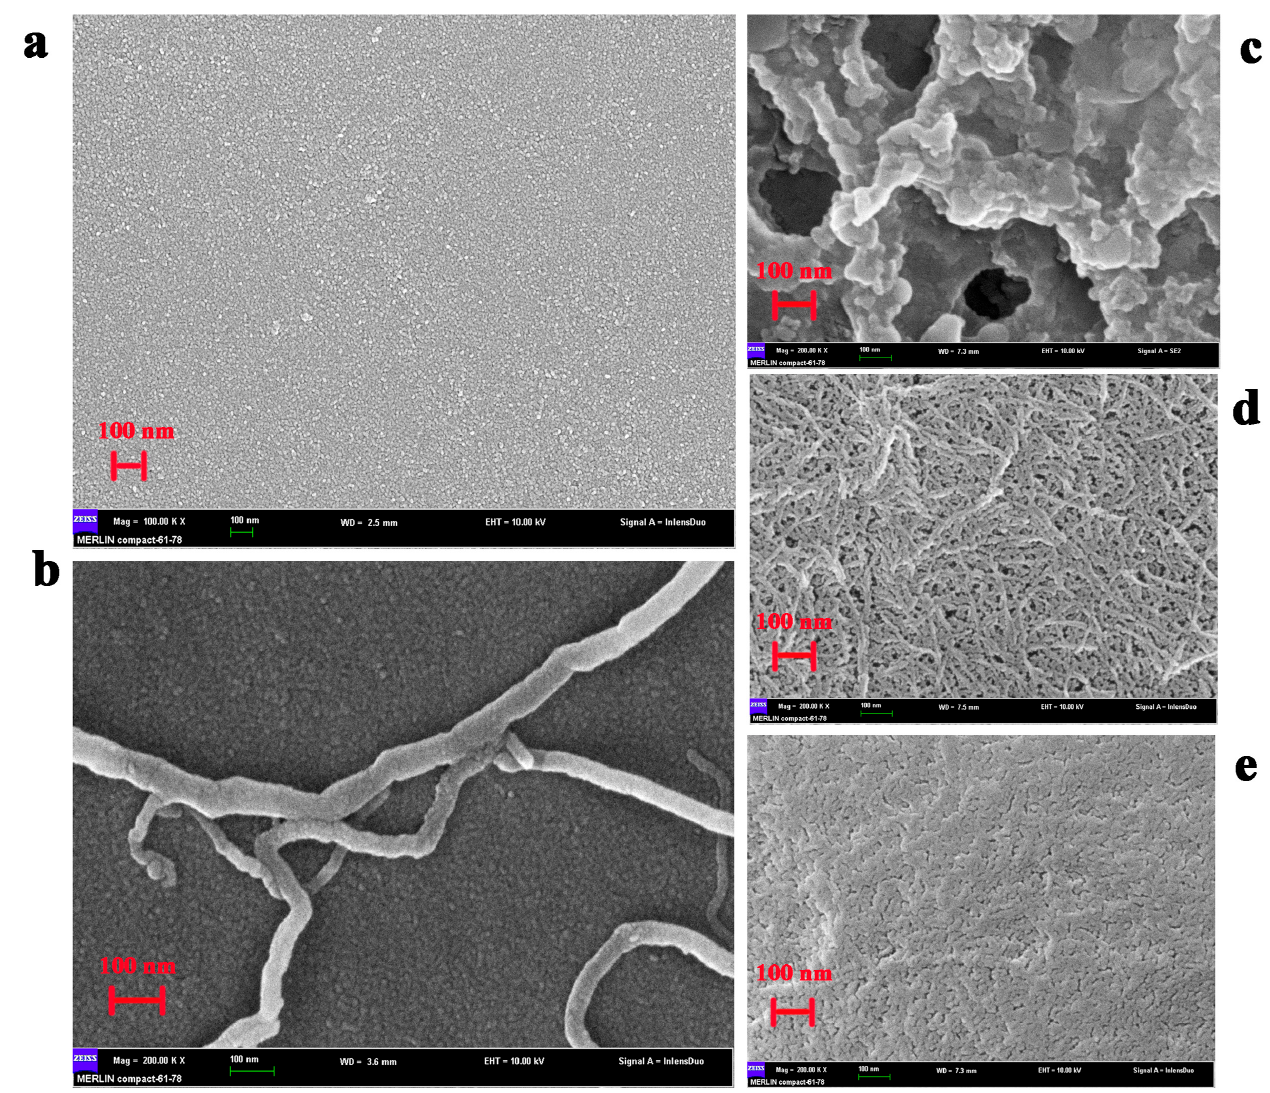
Figure 3. SEM images of the GCE electrode surface modified with distinct methods. ( a ) bare GCE; ( b ) S-MWNT/GCE; ( c ) GA/CS/GDH/S-MWNT/GCE; ( d ) NC/S-MWNT/GCE; ( e )